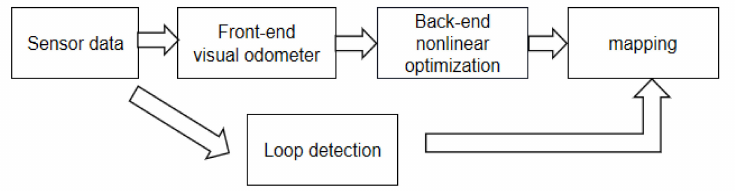
Figure 1. The SLAM Classic Framework. (The framework is mainly composed of the following five parts: sensor, visual odometer, back-end, closed-loop detection, and mapping. Their respective roles are explained in detail in the paragraphs after Figure